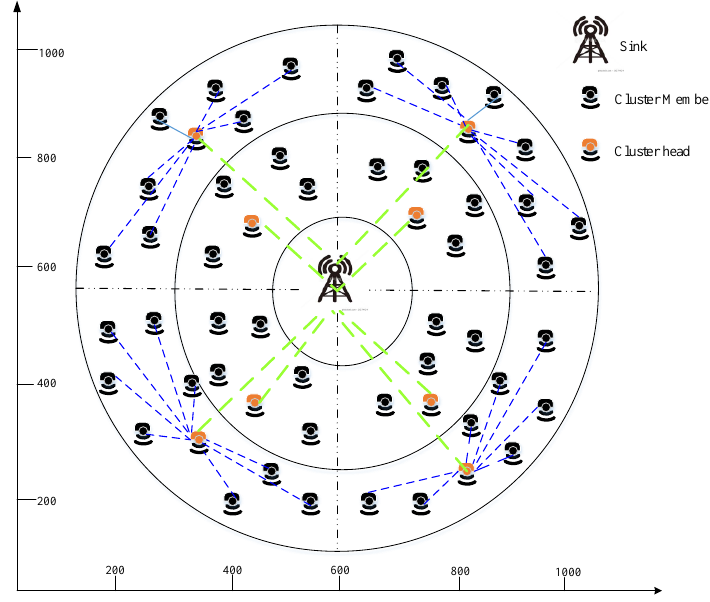
Figure 3. Simulation environment of our work.